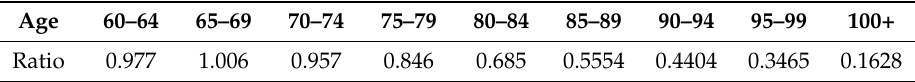
Table 1. Male/female ratio of study region in